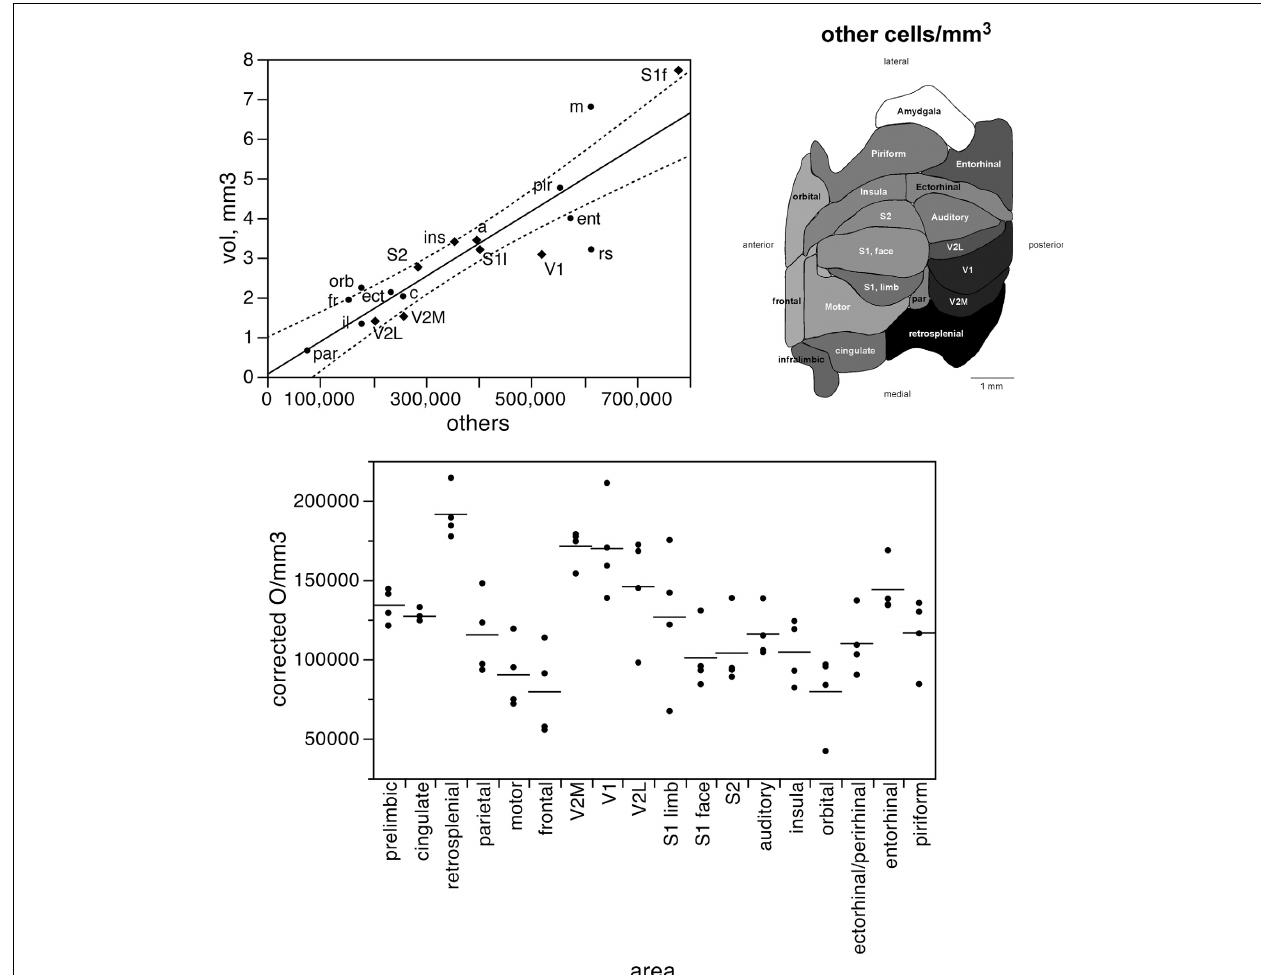
FIGURE 7 | The volume of each functional area varies as a simple shared function of the number of other cells in each area. Top left, area volume plotted as a function of the average number of other cells found in that functional area. The fitted line is the linear function that describes the entire dataset, and the dotted lines indicate the 95% confidence interval of the fitted